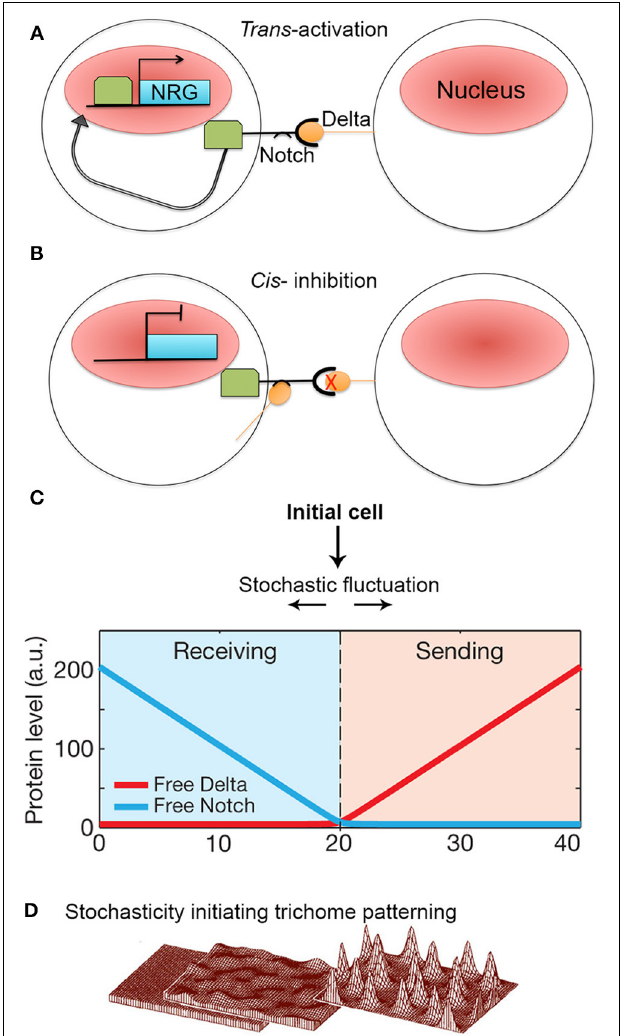
FIGURE 6 | Stochasticity initiates lateral inhibition-based patterning. (A) A simplified model of the Notch-Delta pathway. When transmembrane receptor Notch on one cell interacts with ligand Delta on the neighboring cell, Notch is cleaved and intracellular domain subsequently moves to the nucleus to trans -activate Notch-responsive genes (NRG). (B) However, if Delta interacts with Notch in the same cell, Notch is inhibited and unable to activate NRGs. Additionally, Notch becomes less responsive to trans -Delta. (C) When Notch and Delta are present in the same cell, they mutually inactivate one another. This creates a “switching” environment, where small concentration imbalances between Notch and Delta due to stochastic fluctuations will either cause a cell to transition to a sending state (high delta, low notch) or a receiving state (low delta, high notch) thus activating the patterning process. Reprinted with permission from MacMillan Publishers Ltd: Sprinzak et al. (2010). (D) Computational models of de novo trichome patterning based on Meinhardt’s model, which suggests that trichome patterning is initiated via small stochastic changes in activator and inhibitor concentrations in equivalent cells (left to middle). Regulatory positive feedback loops to amplify small concentration differences. In addition inhibitor factors prevent surrounding cells from differentiating into trichomes producing a spaced pattern (middle to right). Reprinted by permission from MacMillan Publishers Ltd: Hülskamp